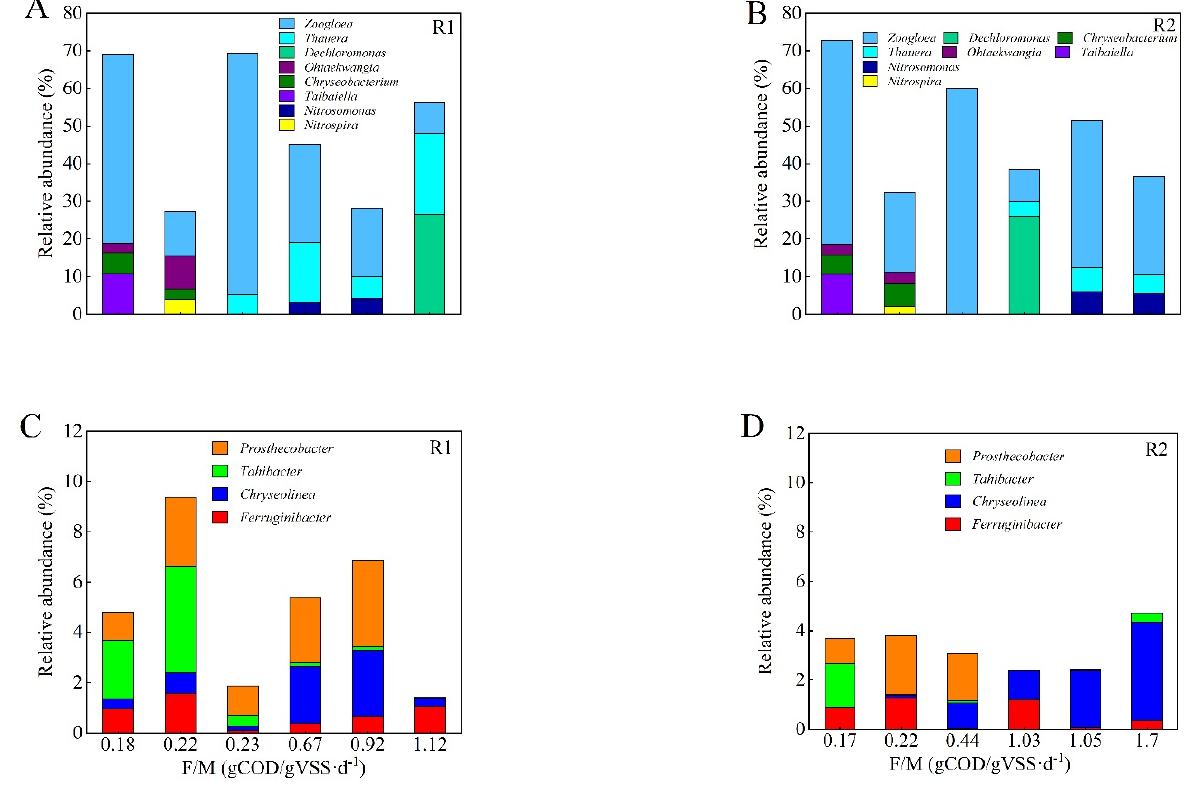
Figure 8. The relationship between F/M and the relative abundance of the predominant genus in the aerobic granules in R1 and R2. ( A , B ), genera with maximum relative abundance higher than 5% in R1 and R2, respectively; ( C , D ), genera with maximum relative abundance lower than 5% in R1 and R2, respectively.